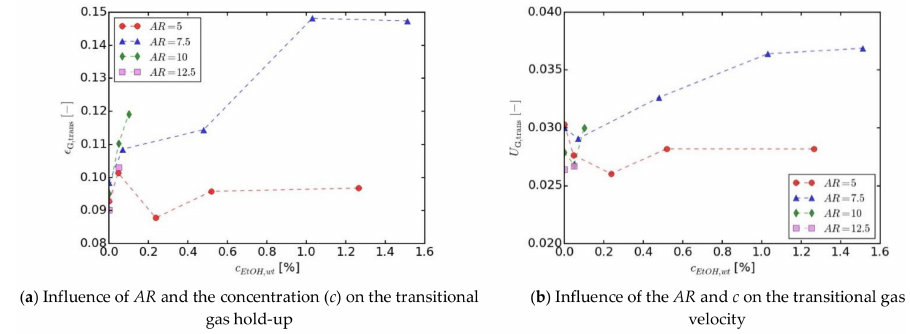
Figure 11. Influence of AR and n * (as defined in Equation (2) on flow regime transition points—data obtained from ref.